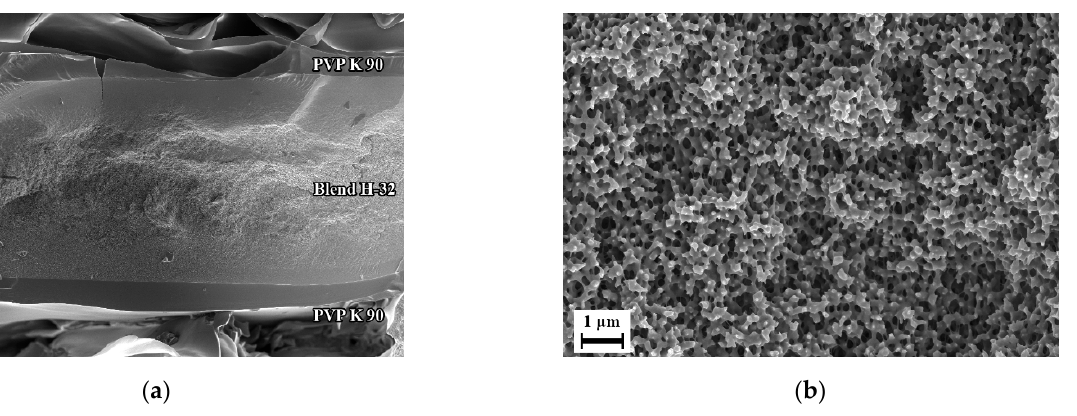
Figure 13. Functioning of sandwich-type sample during batch foaming versus a standard sample.